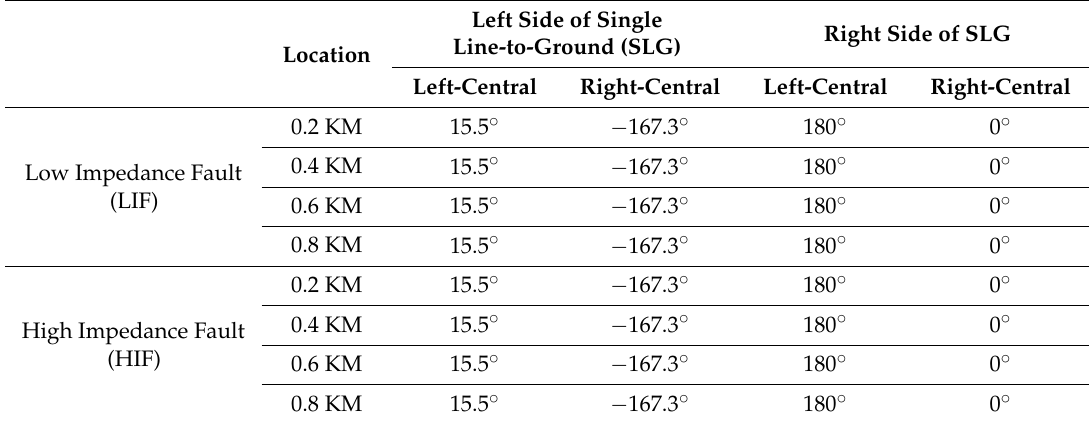
Figure 19. Microgrid network fault. Table 3. Simulation results for faults in different positions.